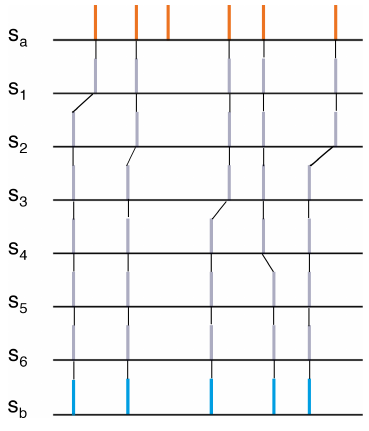
Figure 2. A minimum-cost path is shown to transform S a to S b